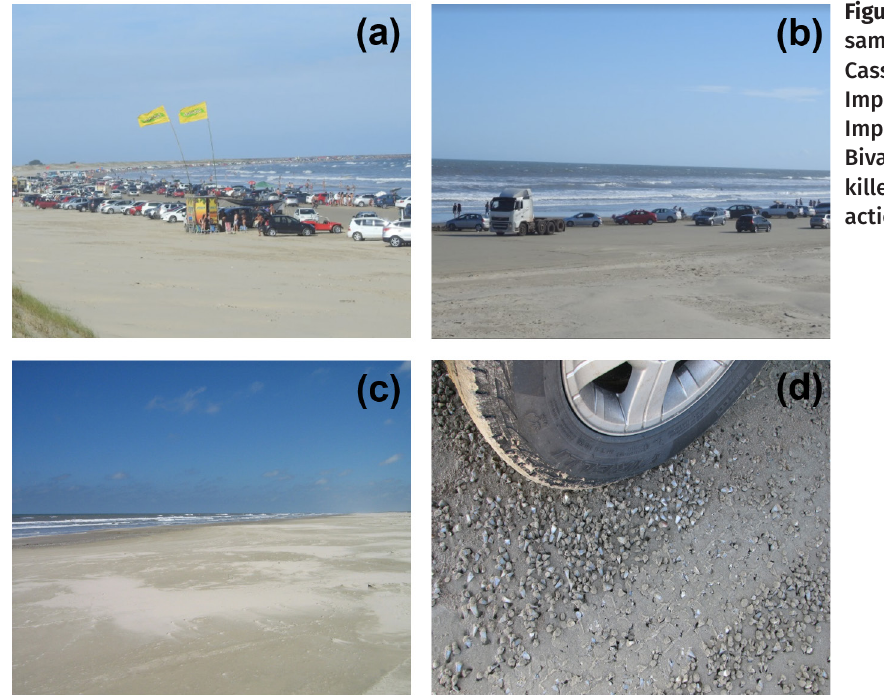
Figure 1. Different sampling sectors of Cassino Beach: (a) High Impact; (b) Moderate Impact; and (c) Control. (d) Bivalve Donax hanleyanus killed by direct vehicle